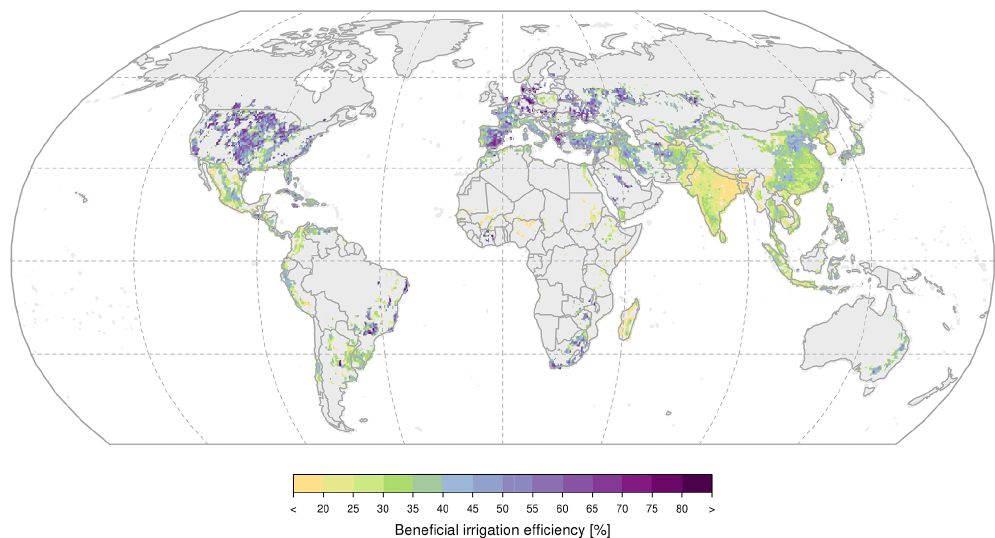
Figure 4. Global patterns of beneficial irrigation efficiency ( E b , ratio of transpired and diverted water) as area-weighted mean over CFTs (exclusive “others” and pastures) and based on the system distribution in Fig.